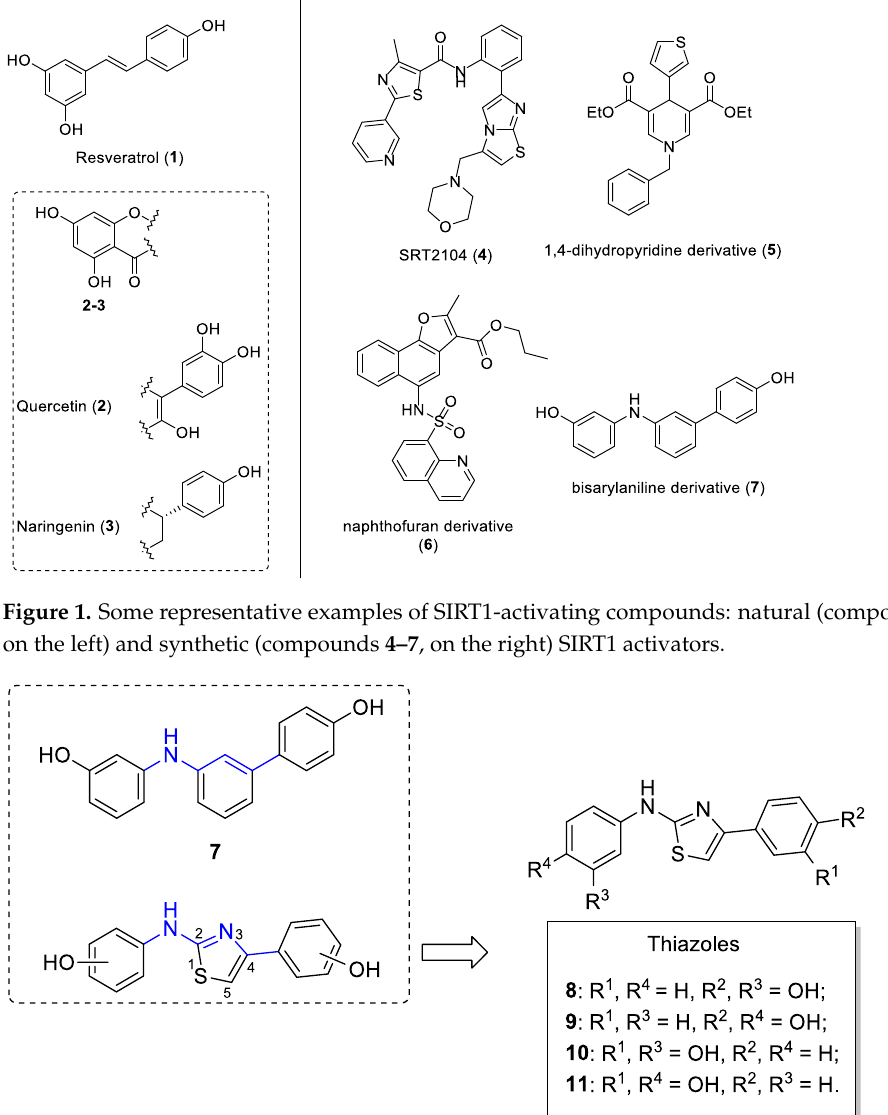
Figure 2. Design of small molecules activating SIRT1. The structure of previously published SIRT1 activator 7 and the general structure of the thiazole class are reported in the dashed box [24]; on the right, the specific structures of the thiazole derivatives 8 – 11 are reported.